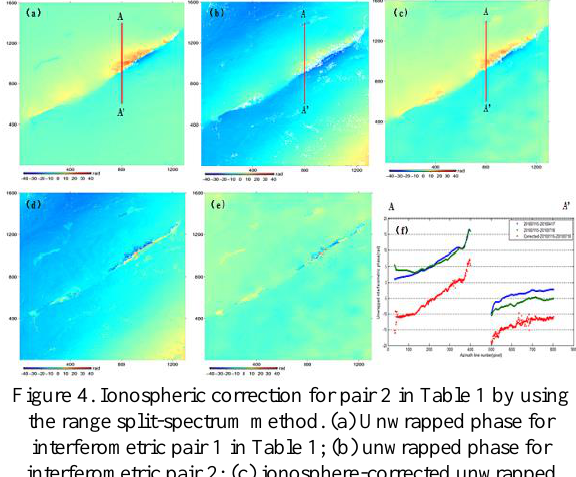
Figure 4. Ionospheric correction for pair 2 in Table 1 by using the range split-spectrum method. (a) Unwrapped phase for interferometric pair 1 in Table 1; (b) unwrapped phase for interferometric pair 2; (c) ionosphere-corrected unwrapped phase for interferometric pair 2 estimated using the range split-spectrum method; (d) phase difference between (a) and (b); (e) phase difference between (a) and (c); (f) the phase values in Figure 3. (a) Topographic map of Yushu earthquake area; (b) the profile A-A’ of (a)-(c). Interferometric phase.